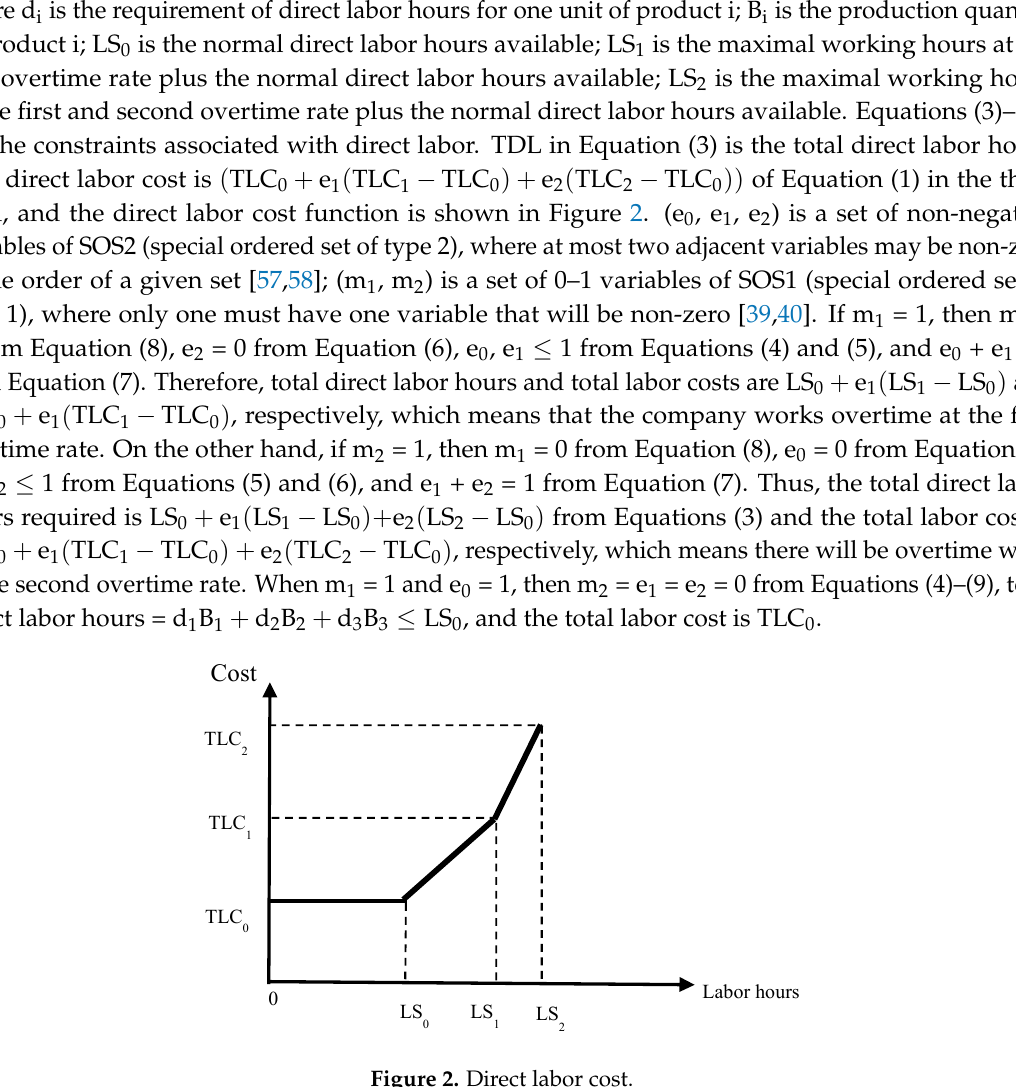
Figure 2. Direct labor cost.